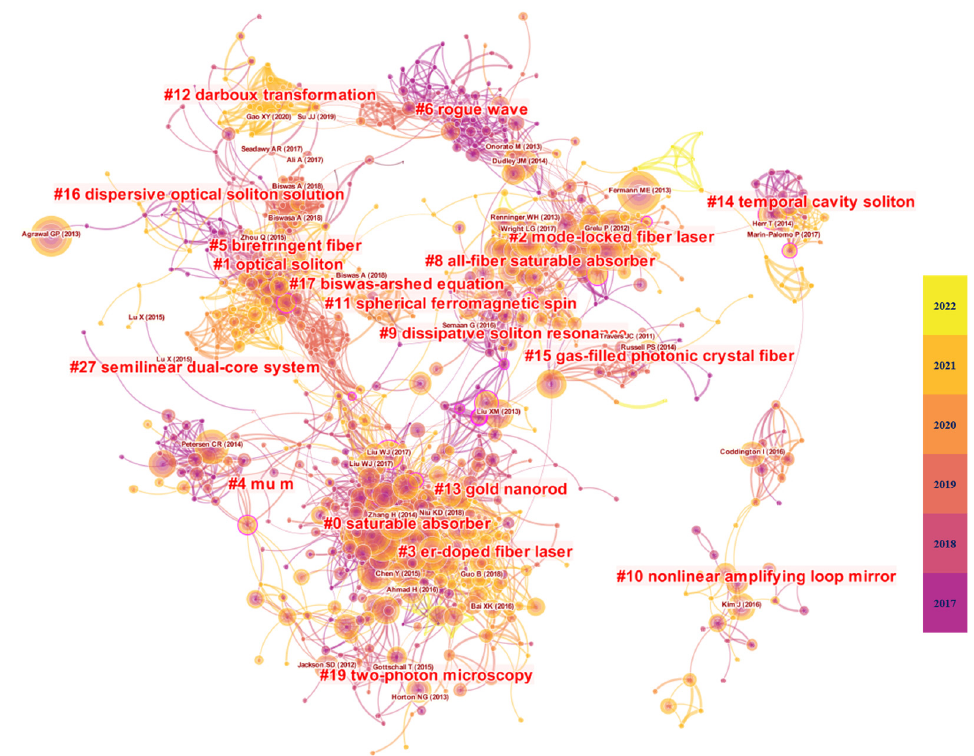
Figure 1. The co-citation network of reference from 2017 to 2022. In the literature co-citation network, the size of the nodes represents the size of the number of citations of the paper, and the color of the network nodes from dark to light indicates the evolution of the research from early to recent. The connection between two papers represents that the papers have a co-citation relationship, and the color of the connection represents the time when the two papers were first cited together. Based on the network clustering algorithm, the literature co-citation network was divided into 19 clusters. Based on the LLR algorithm, the tags of the clusters were extracted from the titles, keywords, and abstracts of the cited papers, which were represented as “# number tags”.